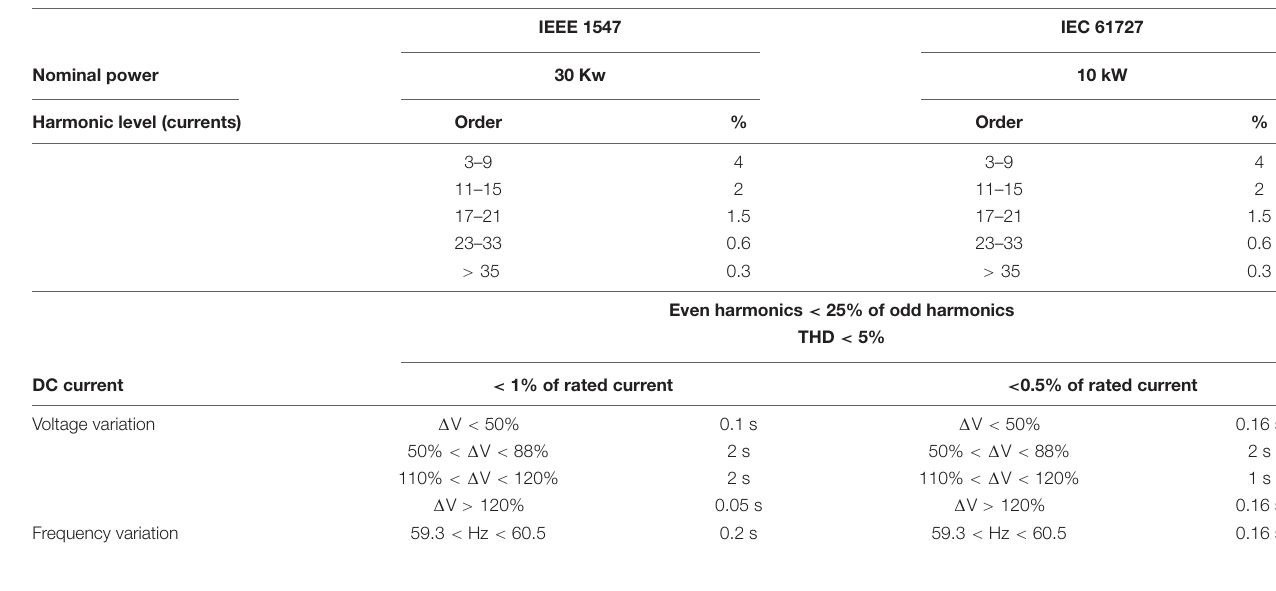
TABLE 1 | Summary of the grid requirements concerning the IEEE 1547 and IEC 61727